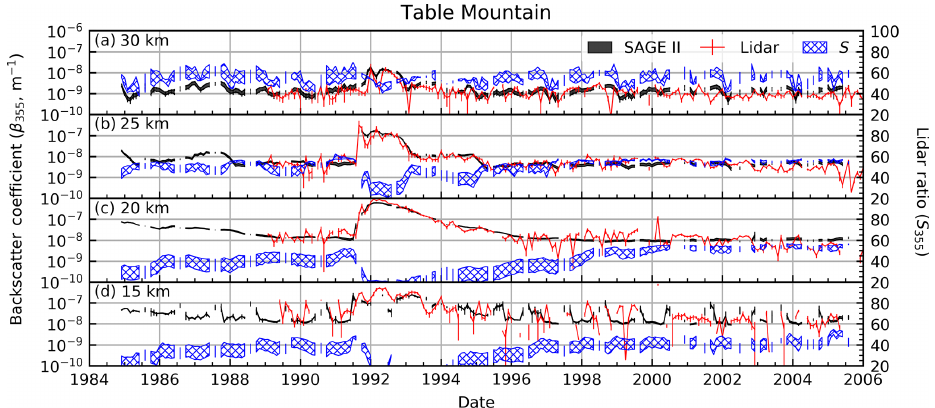
Figure 6. Time series of SAGE II (monthly zonal mean), lidar (monthly mean) backscatter coefficients, and a SAGE-based lidar ratio estimate at 355nm (monthly zonal mean) over the Table Mountain Facility. The spread in the SAGE-derived backscatter and lidar ratios (both coefficients at same wavelength) represents the range of values due to changing the spread ( σ ) of the lognormal distribution. The backscatter upper bound is when σ = 1 . 8 and the lower bound is for σ = 1 . 2 (vice versa for the lidar ratio). Error bars represent standard errors. Altitude bins span ± 2 . 5km.